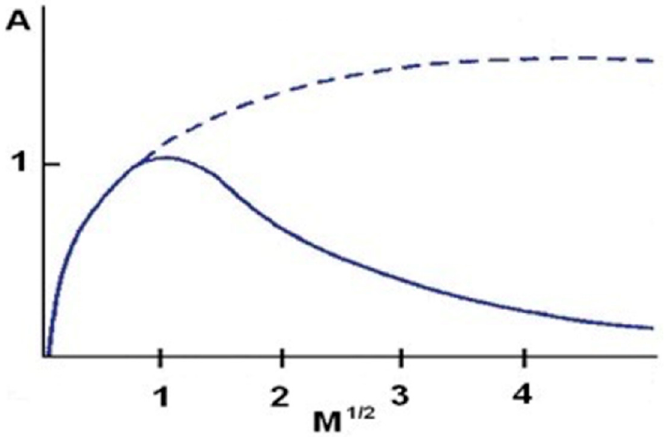
Figure 25. The effect of microwave power (M) on the amplitude (A) of the EPR line widened uniformly (solid line) and non-uniformly (dotted line).